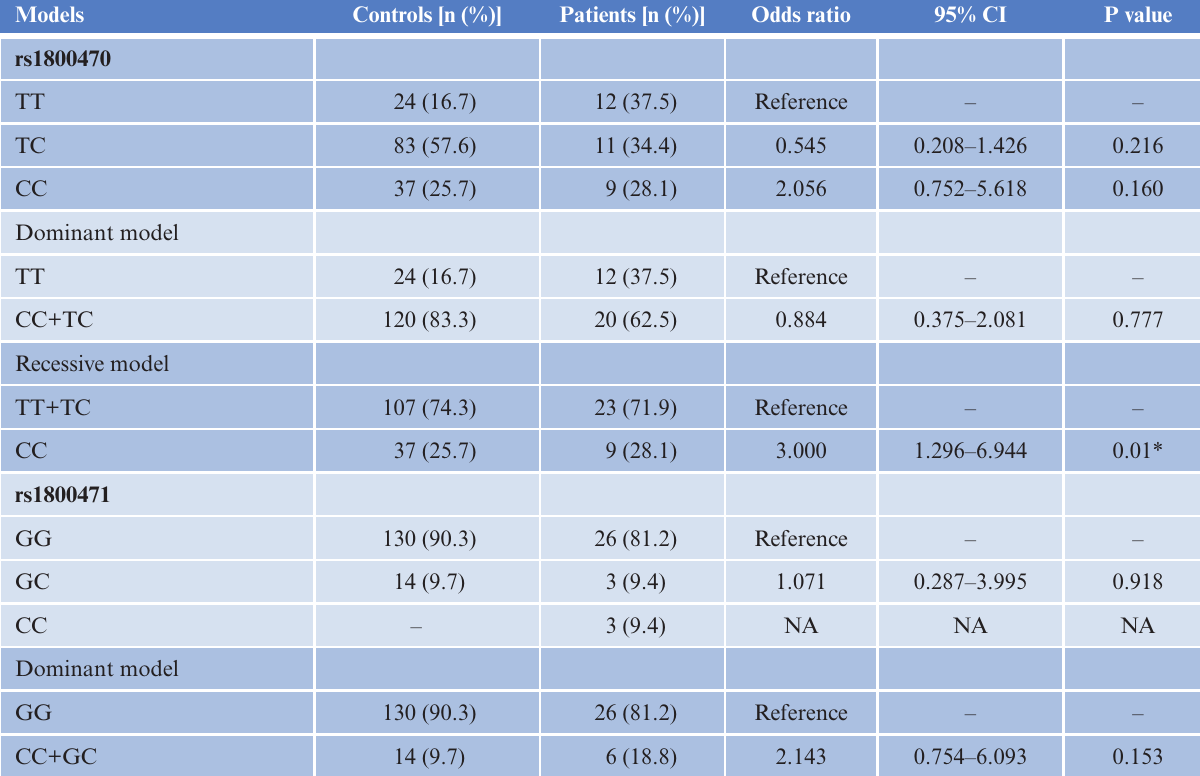
Table 2: Genotypic frequencies in WT and control patients and case-control study for TGFB1 signal peptide region polymorphisms (rs1800470 and